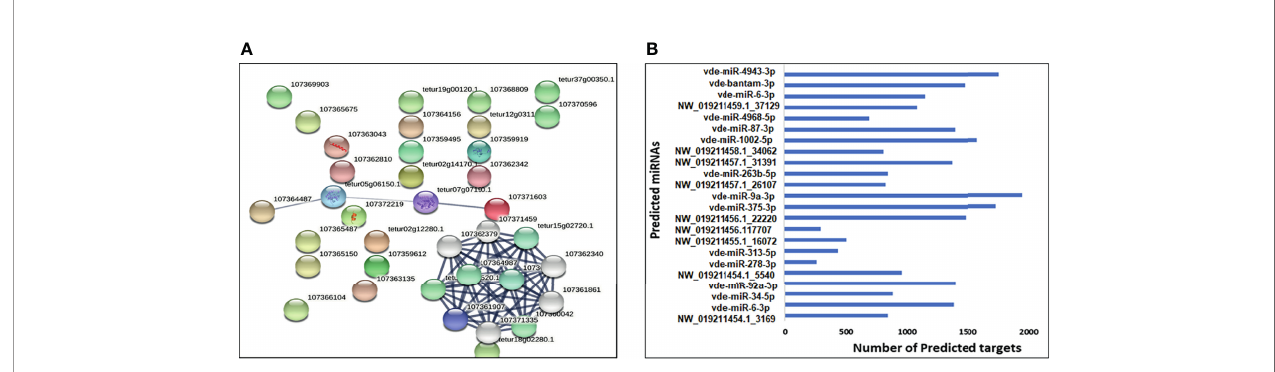
FIGURE 6 | (A) A network built exclusively from Varroa proteins targeted by predicted upregulated/downregulated miRNAs. (B) The total number of predicted target transcripts signi fi cantly upregulated and downregulated in female Varroa miRNAs relative to male